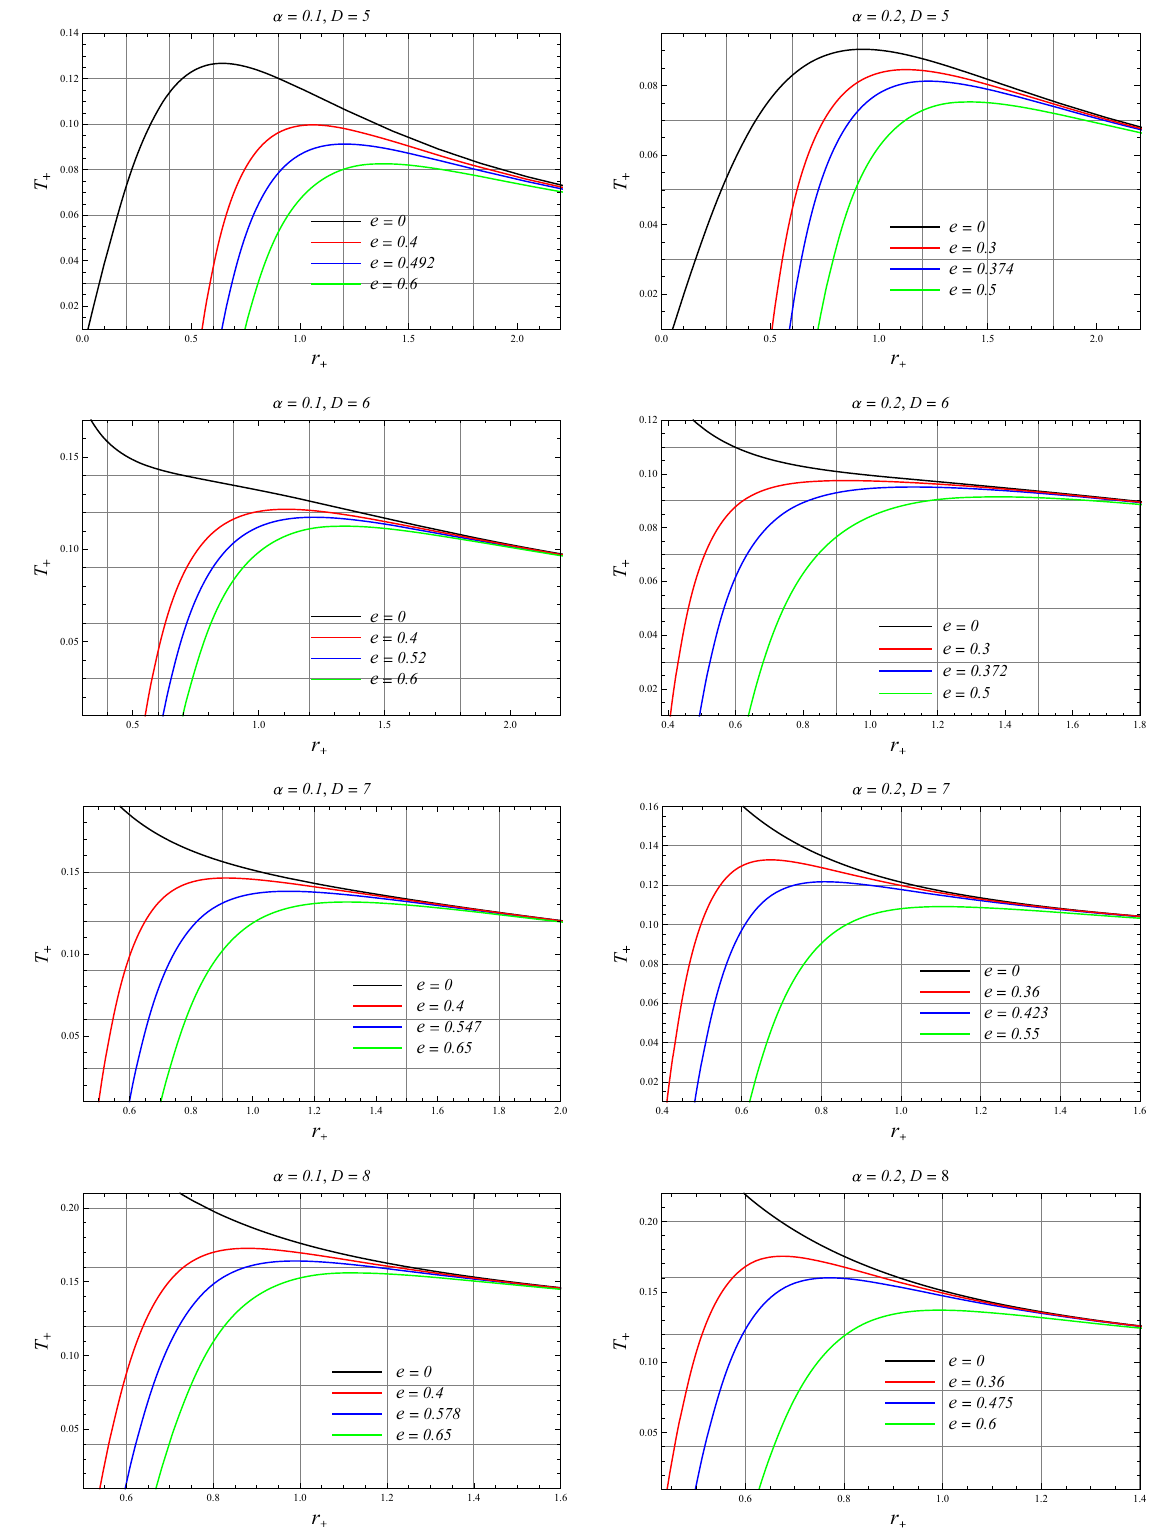
Fig. 2 The Hawking temperature T + vs horizon radius r + in various dimensions D = 5, 6, 7, and 8 (top to bottom) for different values of charge ( e ) with Gauss–Bonnet coupling parameter α = 0 . 1 and 0.2 (left to right) with μ (cid:9) =